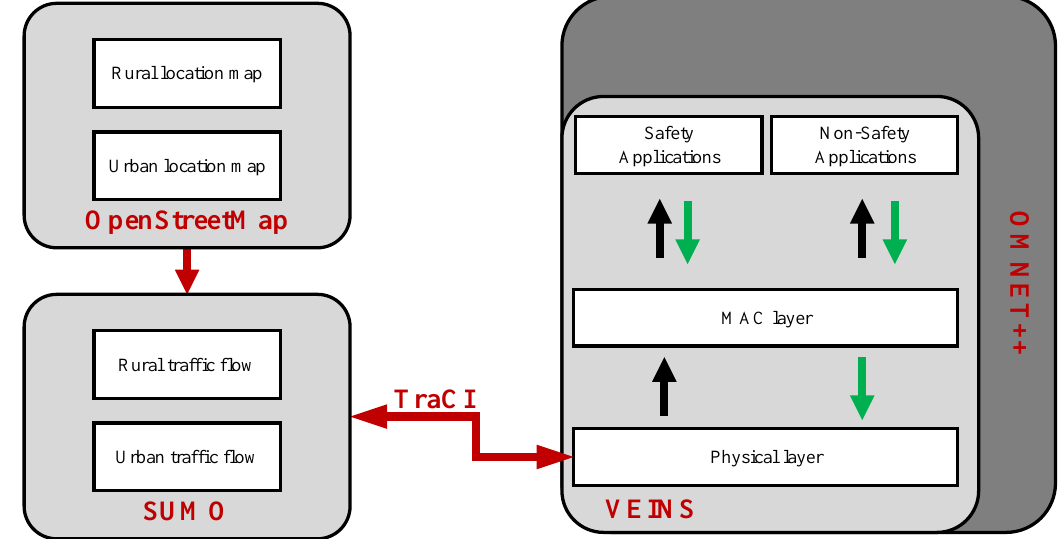
Figure 5. Workflow of Veins Simulation